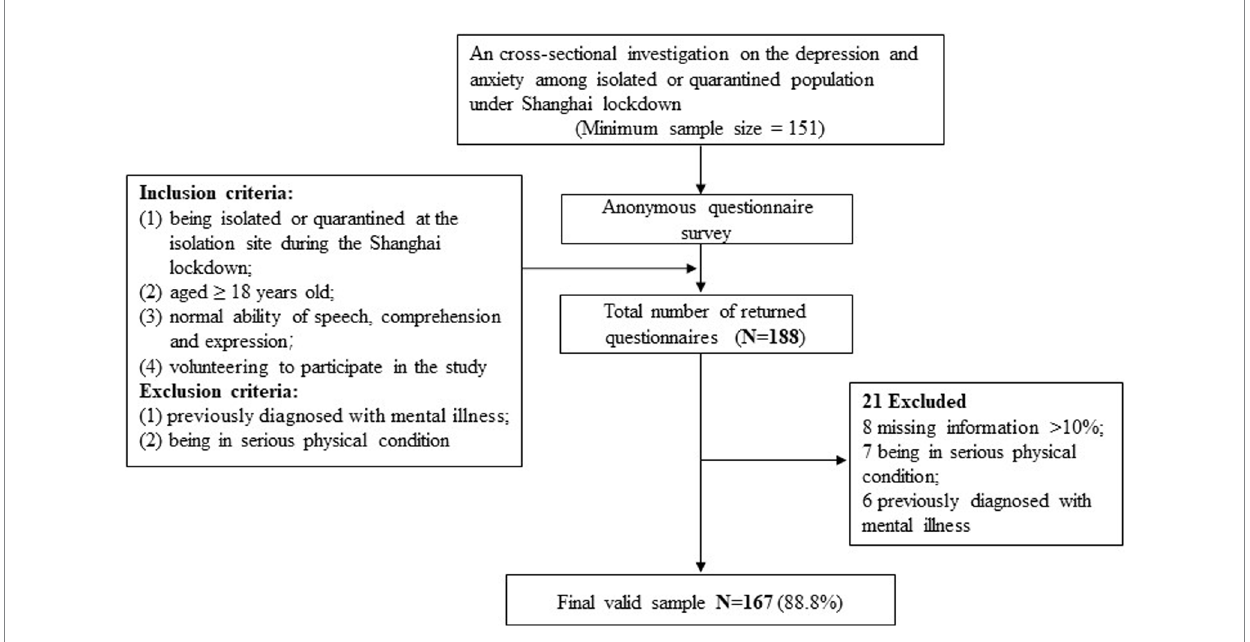
FIGURE 1 Flow chart of the enrollment of study